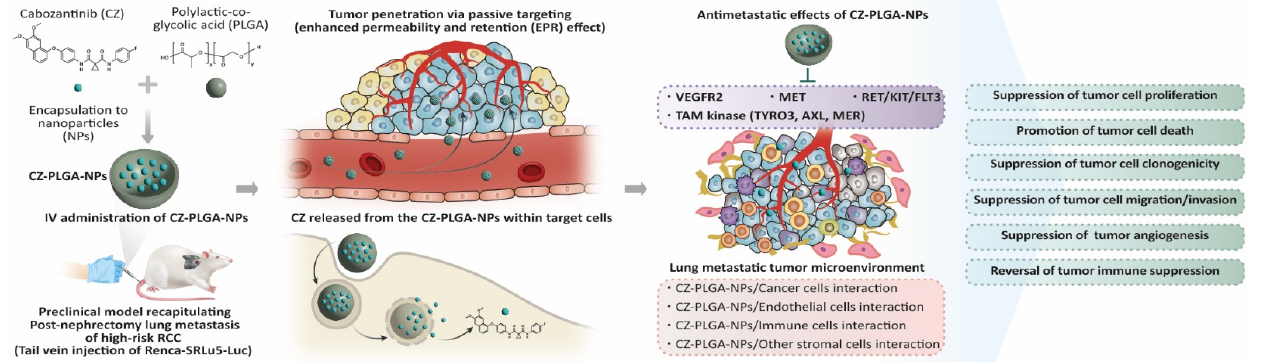
Figure 9. Graphical representation of potential models of anti-tumor activity of CZ-PLGA-NPs against Renca-SRLu5-Luc RCC lung metastasis.